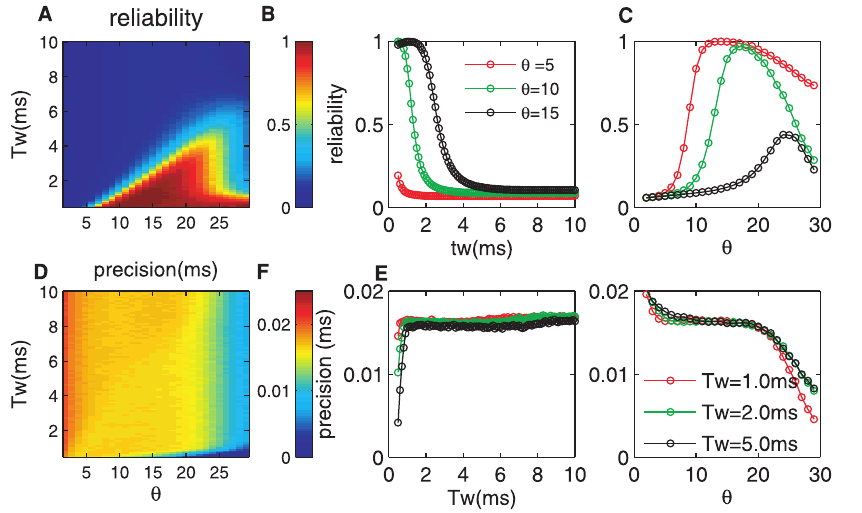
Figure 5. Influence of the refractory period on the detection reliability and precision. (A) The reliability as a function of T w and h . (B, C) h and T w dependence of the detection reliability respectively. (D) The detection precision as a function of T w and h . (E, F) h and T w dependence of the precision respectively. The refractory period T rCD ~ 5 : 0 ms. The parameters for the LIF neuron are V th ~{ 40 mV, V r ~{ 65 mV and t m ~ 10 ms. Other parameters are N ~ 100 and D ~ 20 mV/ms.